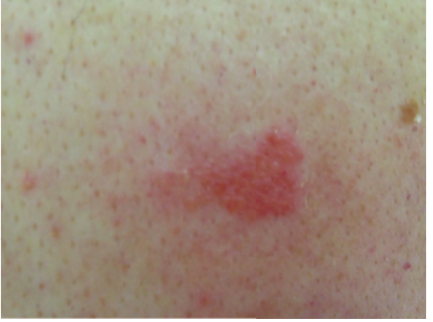
Figure 2: Positive open patch test result with Mandragora